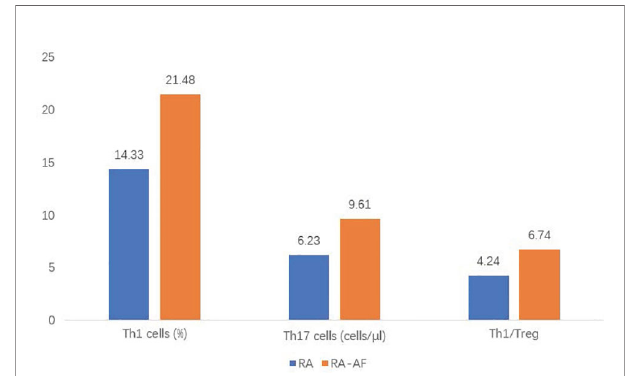
FIGURE 2 | Comparison of proportions of T helper (Th)1, Th17, and Th1/T- regulatory (Treg) cells between rheumatoid arthritis (RA) and RA-atrial fi brillation (AF) groups.